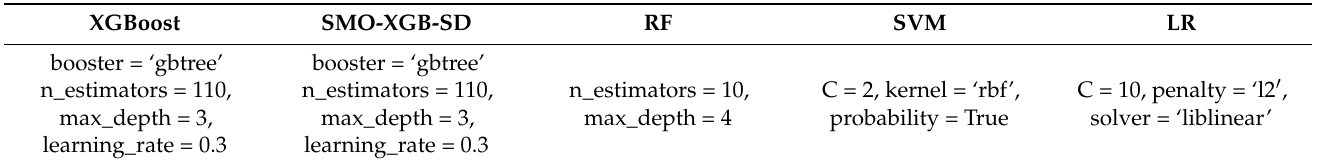
Table 3. Parameter settings of SMOTE-XGBoost-Ship detention model (SMO-XGB-SD), XGBoost, random forest (RF), sup- port vector machine (SVM), and logistic regression (LR) algorithms.